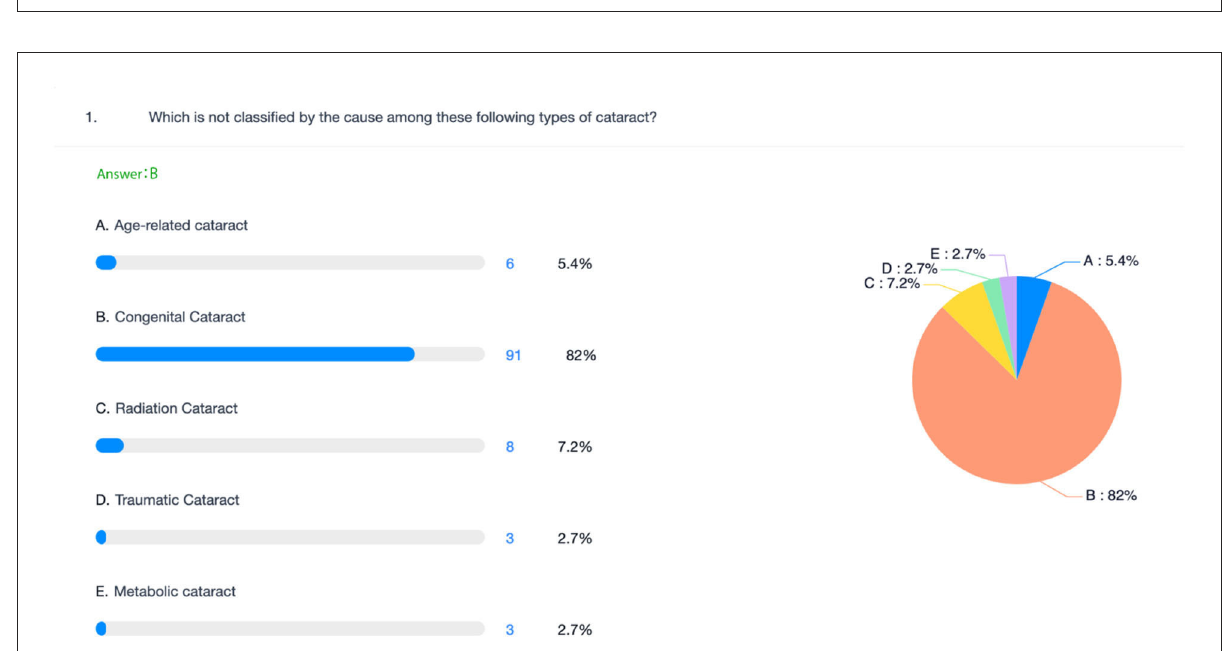
FIGURE6 The discussion of TBL increases interactions between classmates or